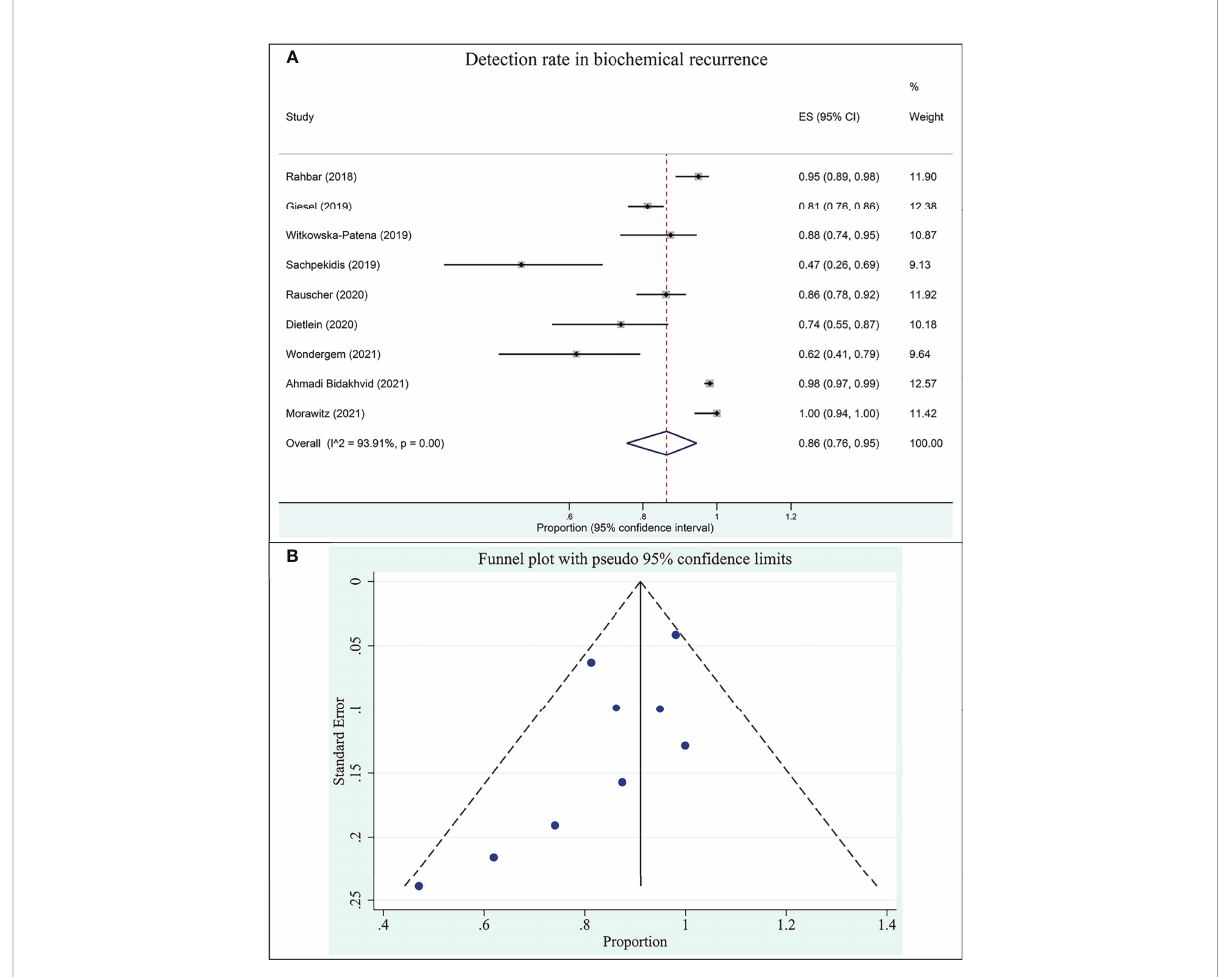
FIGURE 4 Plot of the pooled detection rate of 18 F-PSMA-1007 PET/CT for prostate cancer in biochemical recurrence (A) and related funnel plot for publication bias assessment ( B